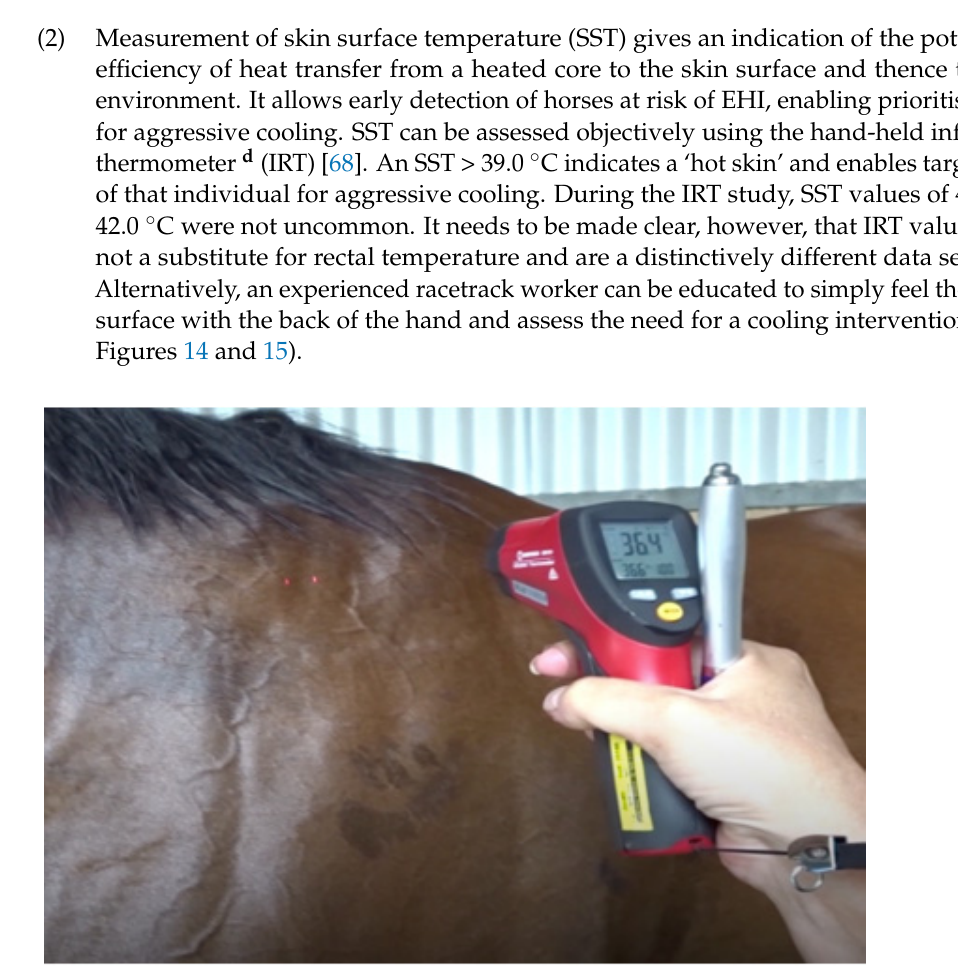
Figure 14. The infrared thermometer enables an objective assessment of skin surface temperature. Source—J Equine Vet Ed, 2021.